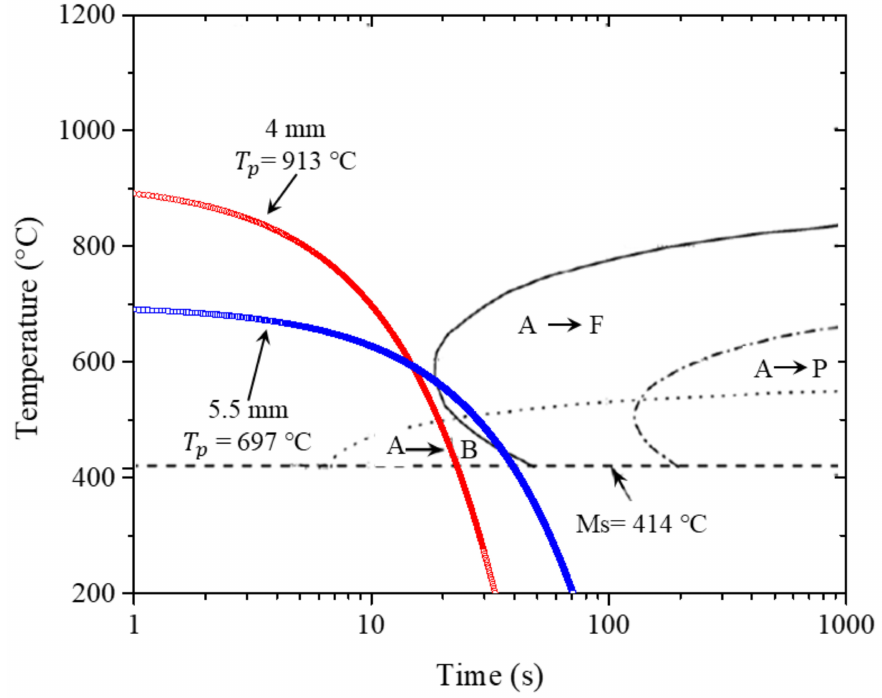
Figure 6. Experimental cooling rates for the LT-HAZ and HT-HAZ of the DP980 welded joints and its corresponding time-temperature-transformation diagram